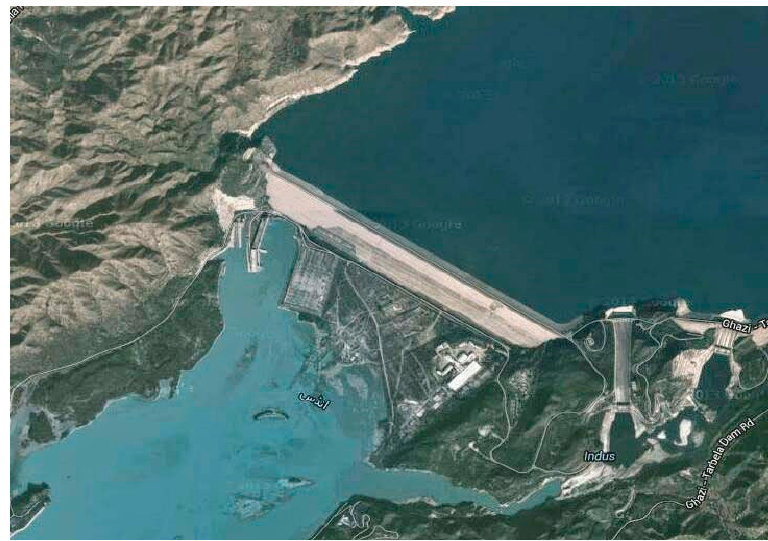
Figure 3. Aerial view of Tarbela Dam Hydroelectric Project